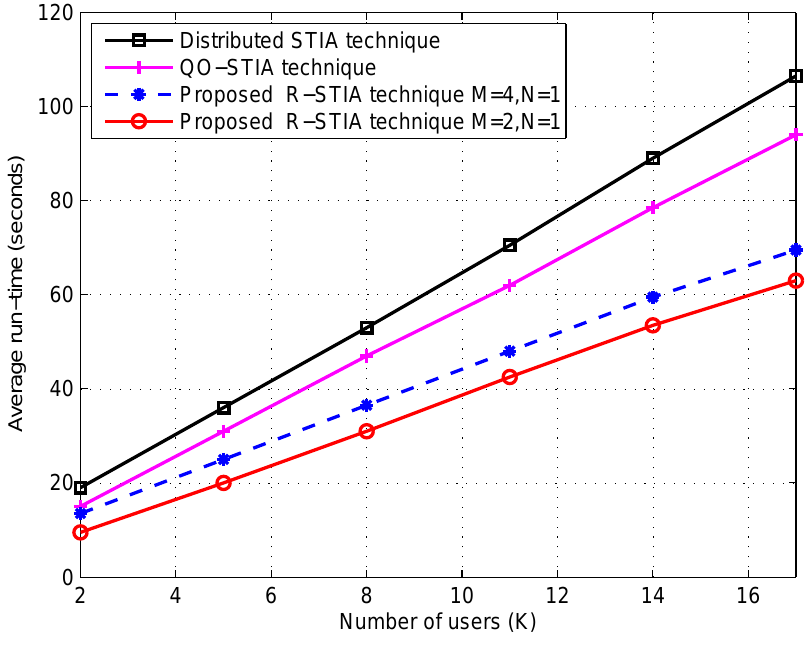
Figure 10. Average run-time versus the number of